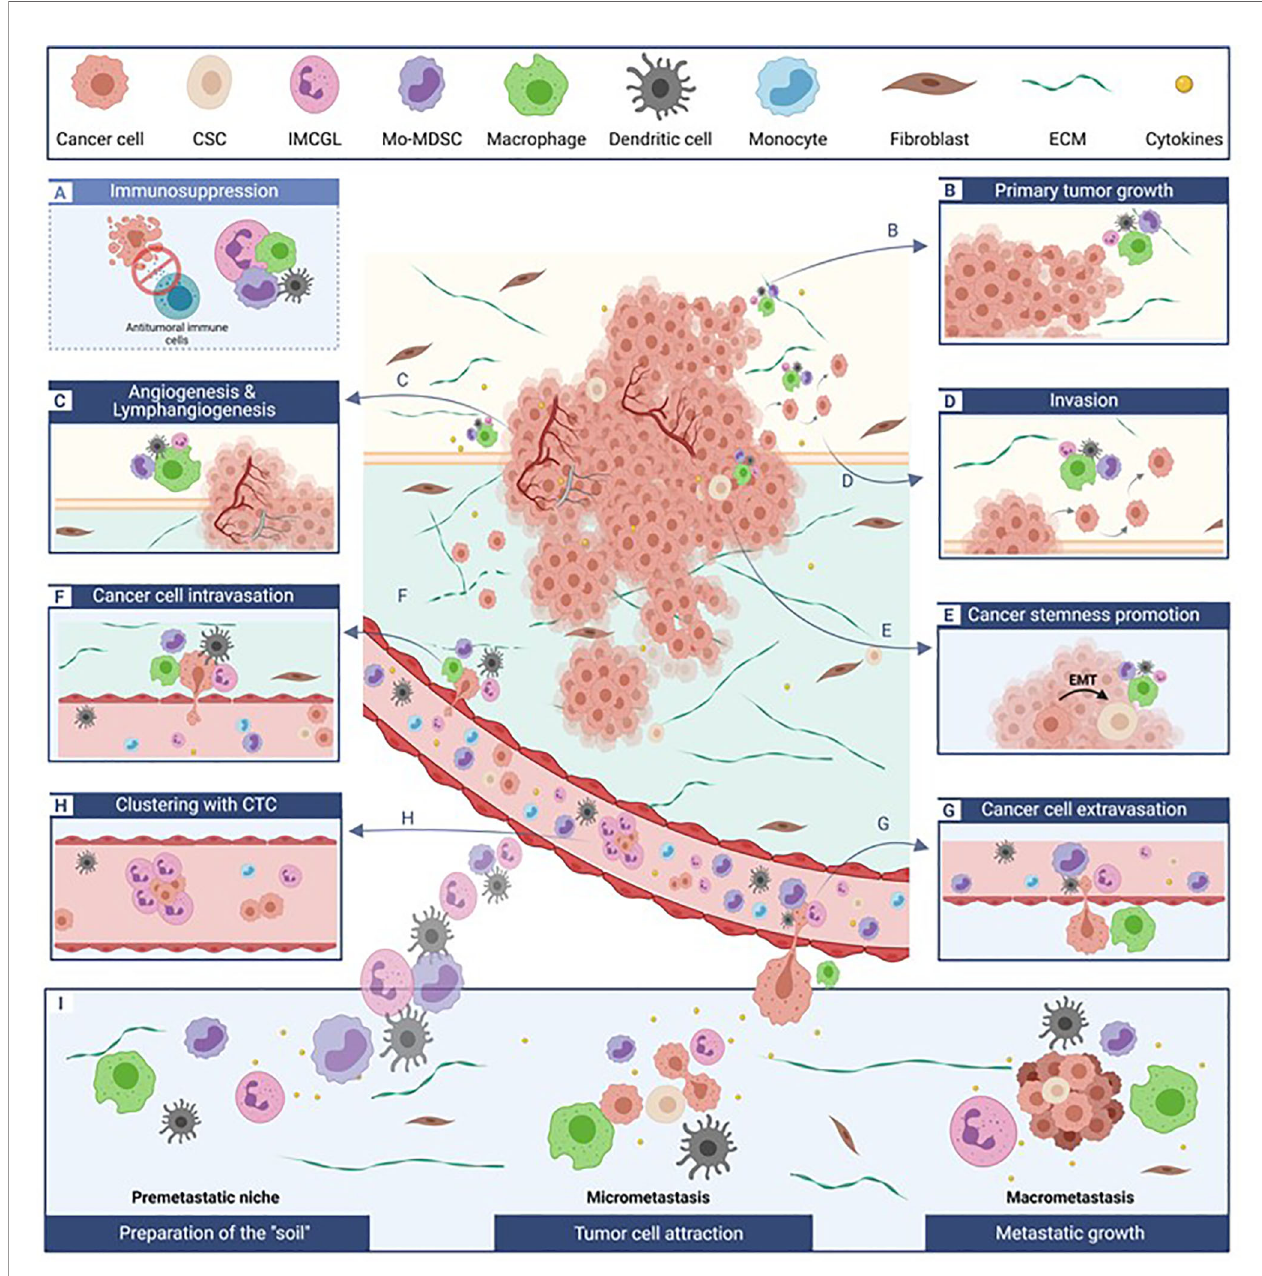
FIGURE 1 | Tumor-promoting myeloid cells critically affect multiple and distinct steps of cancer development. Besides impairing anti-tumor immunity. (A) , dedicated subpopulations of myeloid cells differentially impact primary tumor survival and growth (B) , tumor vascularization (C) , local tissue invasion (D) cancer stemness (E) , tumor cell intra- (F) and extravasation (G) in and from blood vessels, associate with circulation tumor as bene fi cial clusters (H) , and participate to metastatic site preparation and development (I) . The relative contribution of each myeloid cell subset to a speci fi c process (each illustrated in a separate box) is depicted by the differential size of the cells. CSC, cancer stem cells; CTC, circulating tumor cells; ECM, extra-cellular matrix; EMT, epithelial-to-mesenchymal transition; IMCGL, immunosuppressive myeloid cells from granulocytic lineage; Mo-MDSCs, monocyctic myeloid-derived suppressor